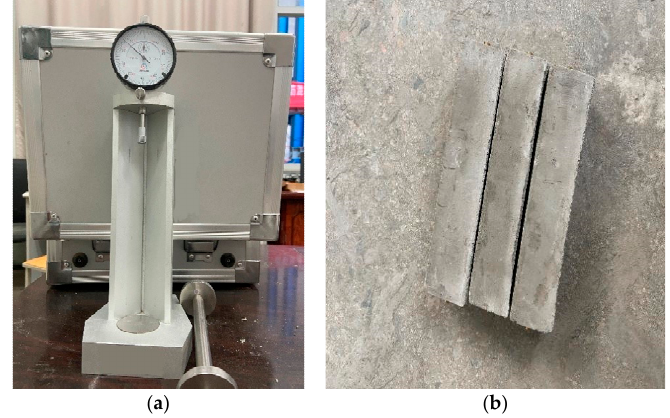
Figure 4. Drying shrinkage test: ( a ) comparator; ( b ) drying shrinkage specimen.